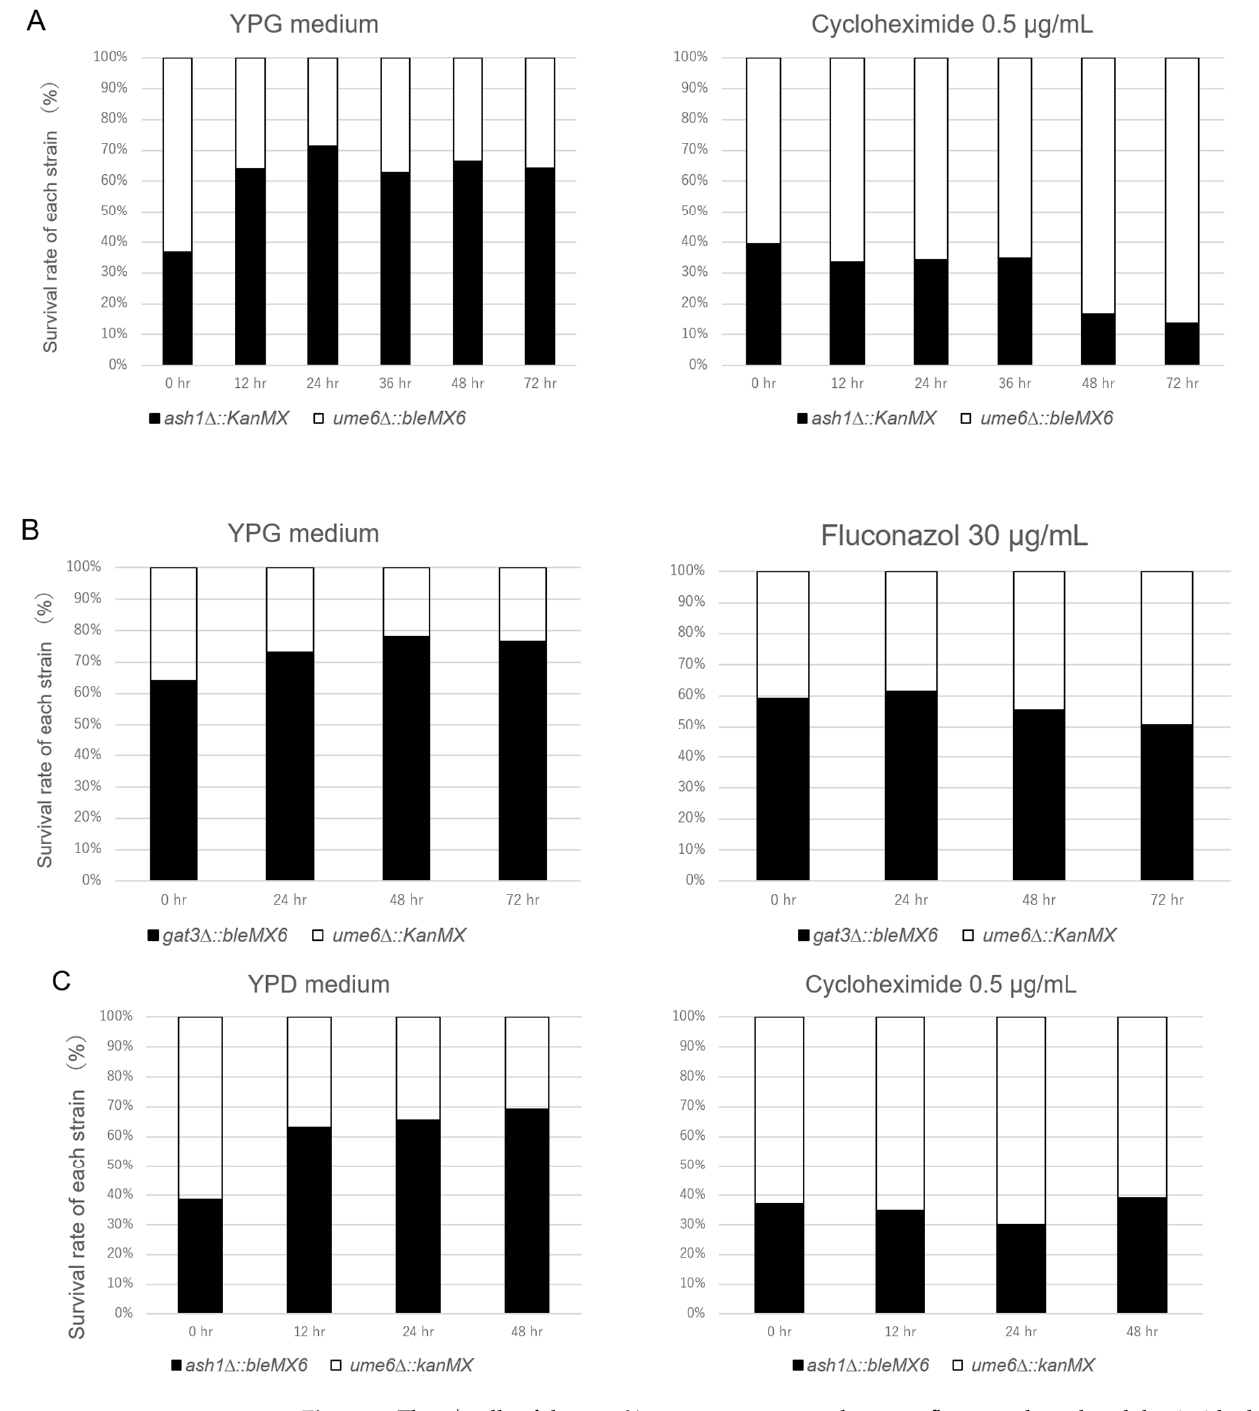
Figure 2. The ρ + cells of the ume6 ∆ mutant are more tolerant to fluconazole and cycloheximide than those of the ash1 ∆ and gat3 ∆ mutants in the cocultivation assays. ( A ) Changes in the survival rates of each strain after cocultivation of the ume6 ∆ :: bleMX6 and ash1 ∆ :: KanMX strains in YPG medium with (right) and without (left) of 0.5 µ g/mL cycloheximide. ( B ) Rates of viable cells of each strain after cocultivation of the gat3 ∆ :: bleMX6 and ume6 ∆ :: KanMX strains using YPG medium with (right) and without (left) 30 µ g/mL fluconazole. ( C ) Changes in the survival rates of each strain after cocultivation of the ash1 ∆ :: bleMX6 and ume6 ∆ :: KanMX strains in YPD medium with (right) and without (left) of 0.5 µ g/mL cycloheximide.